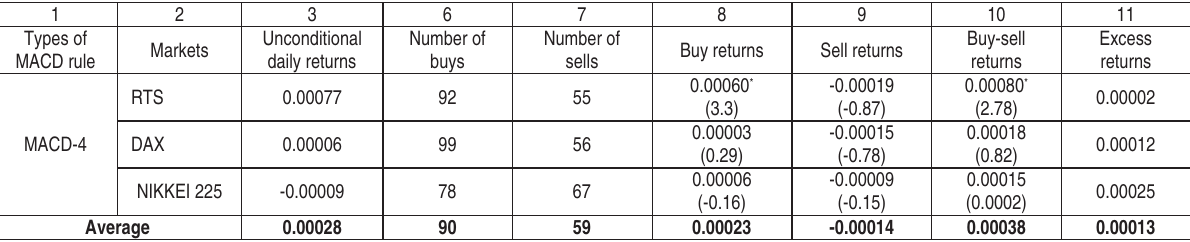
Table 3. Results of MACD-4 trading strategy